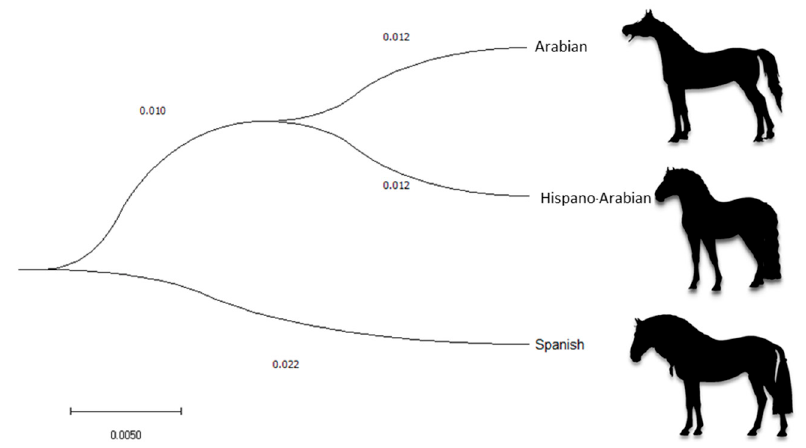
Figure 3. Cladogram constructed from Nei’s Distances between Arabian purebred (PRá), Spanish purebred (PRE), and Hispano-Arabian (Há) horse breeds.